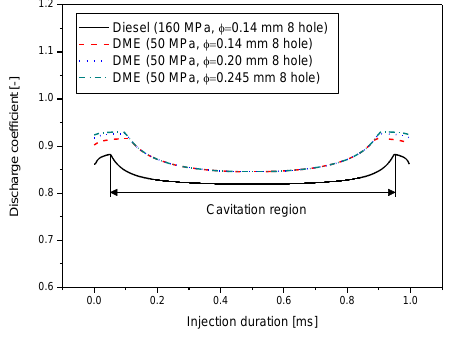
Figure 9. Discharge coefficient during injection. Table 3. Prediction of cavitation conditions for diesel and DME.